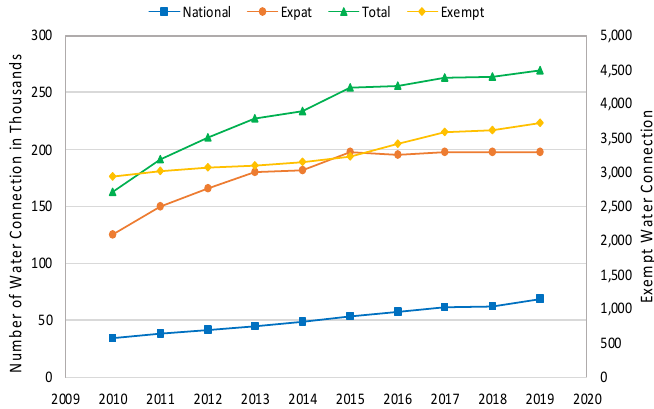
Figure 4. Number of residential connections (2010–2019).